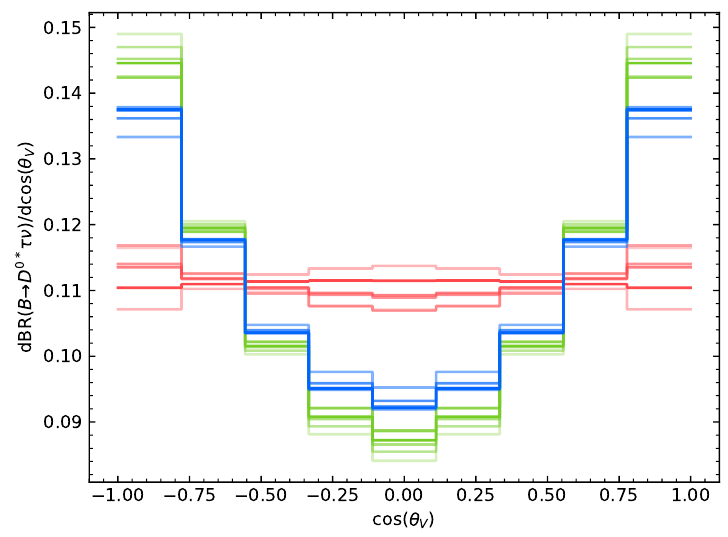
Figure 4 . cos( (cid:18) V )-distributions of the decay (cid:22) B ! D 0 (cid:3) (cid:28) (cid:0) (cid:22) (cid:23) (cid:28) corresponding to three sample points and the BPs. Distributions corresponding to the same cluster are shown in the same colour (match- ing the colour scheme of (cid:12)gure 3), with the sample distributions faded out slightly.